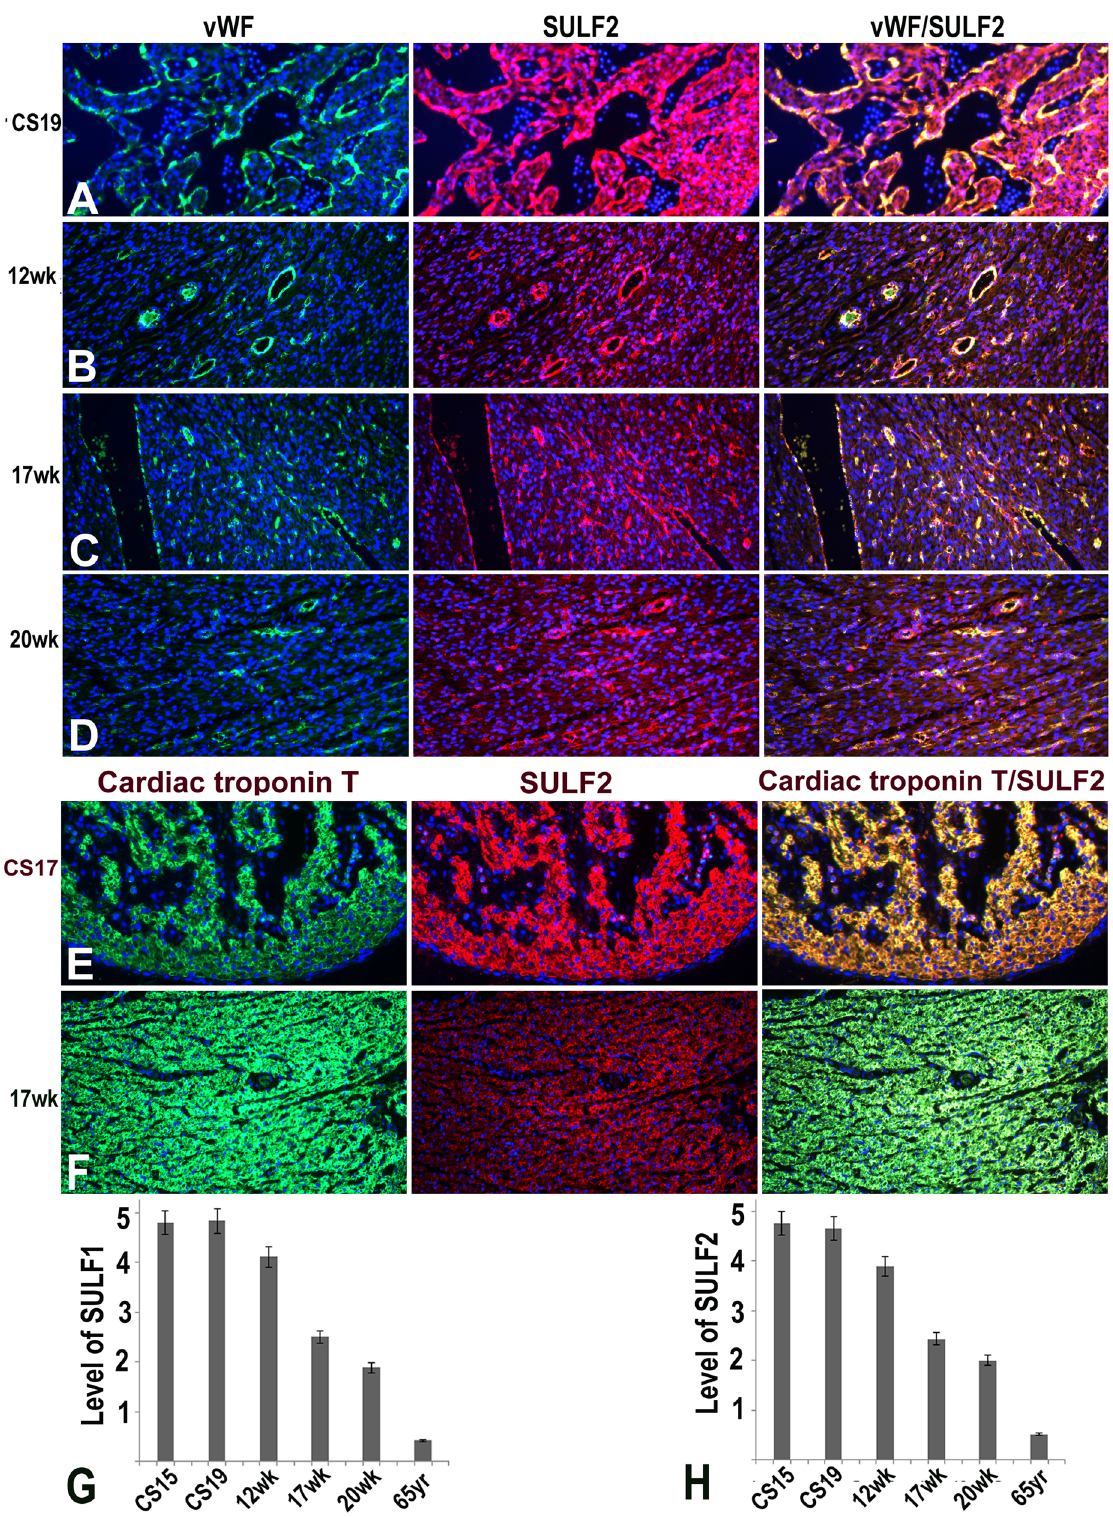
Figure 3. Changing levels of SULF2 and vWF expression detected by double immunofluorescence during cs19, 12 week, 17 week and 20 week of growth highlighting SULF2 and vWF co-expression in endothelial cells (A–D) . SULF2 expression unlike vWF is also observed in cardiomyocytes. As was the case for SULF1, (E,F) also demonstrate SULF2 co-expression with cardiac troponin T in cardiomyocytes. (G,H) demonstrate changing levels of SULF1 and SULF2 expression quantified using volocity software in the adult and embryonic/fetal myocardial